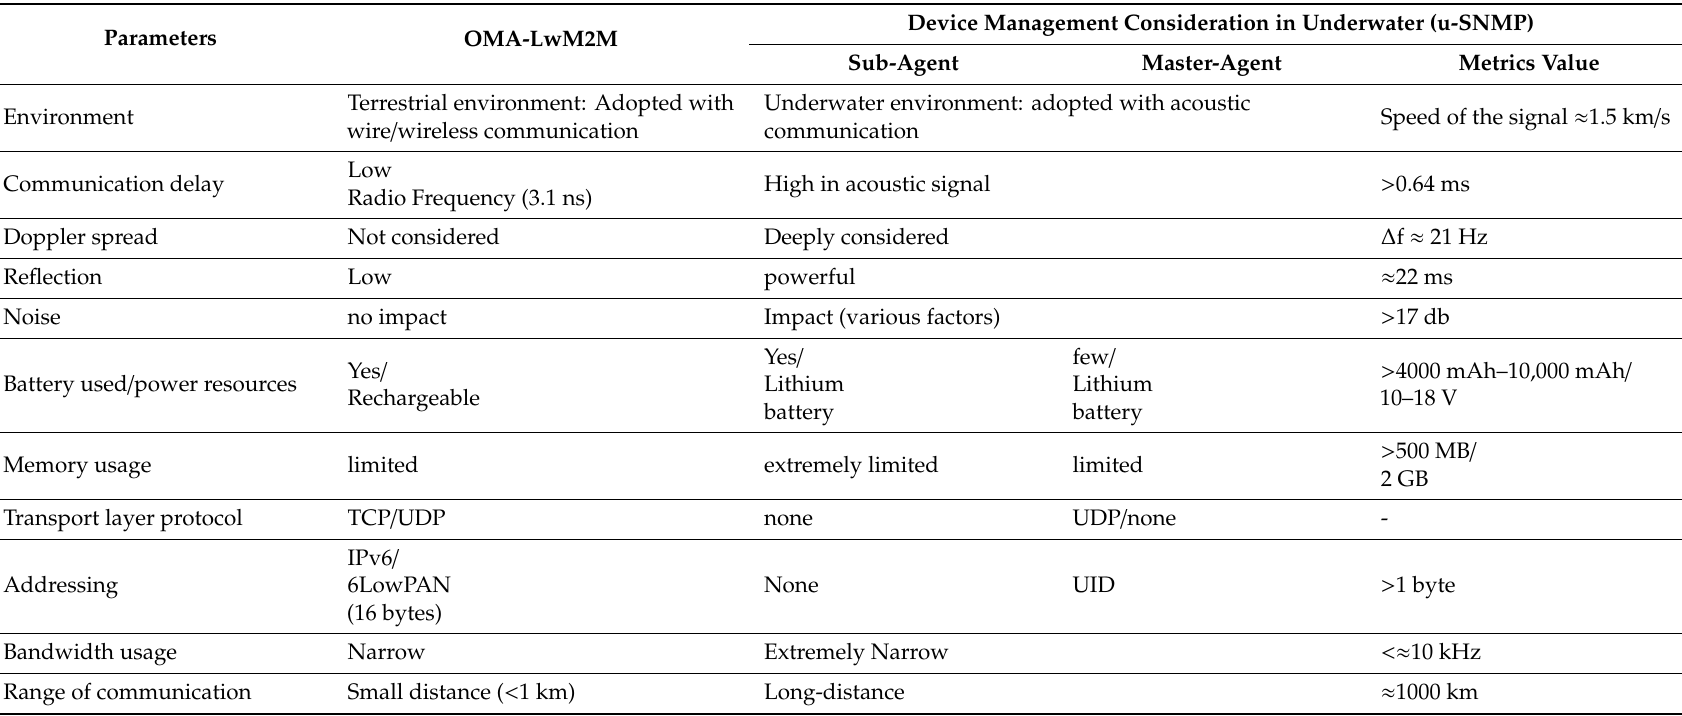
Table 3. Environmental setup between NMS and U-NMS